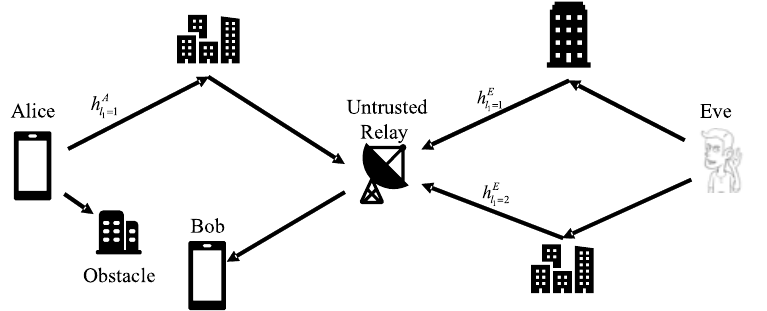
Figure 1. System model: Alice communicates with Bob with aid of amplify and forward (AF) relay; Eve is a would-be intruder impersonating